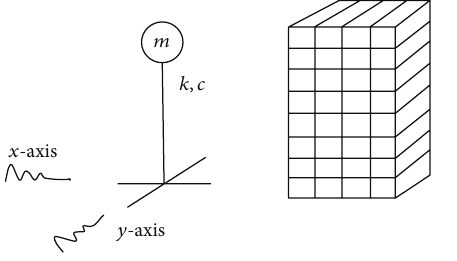
Figure 1: Bidirectional ground forces that are exerted on the build- ing structures.